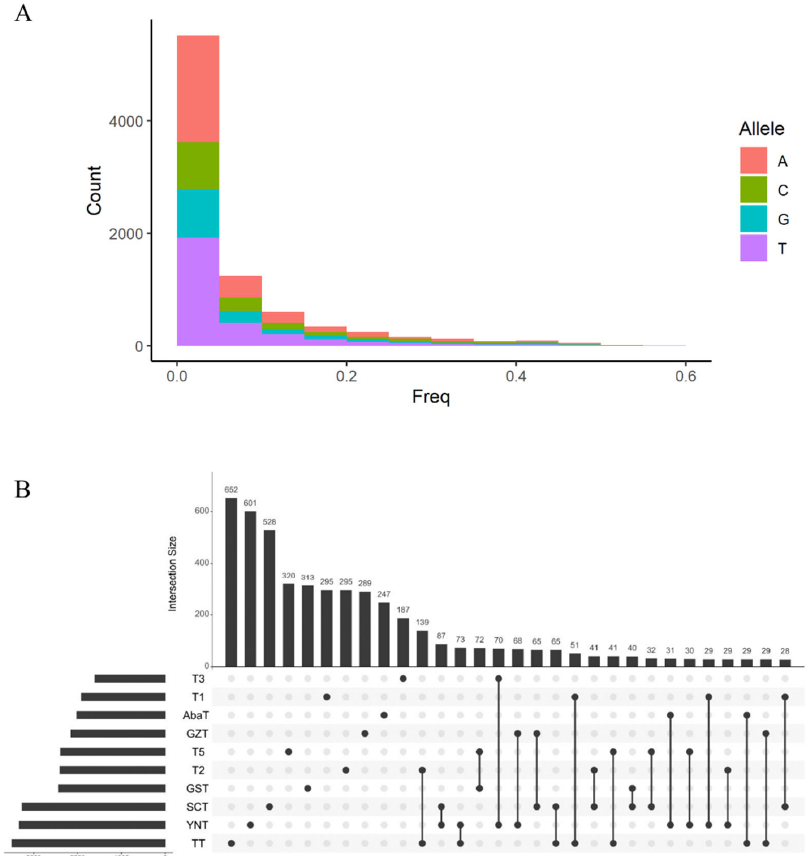
Figure 3. Distribution of deleterious variants. The frequency spectrum of deleterious variants ( A ). Intersect plot of deleterious variant among 10 Tibetan pig populations ( B ).